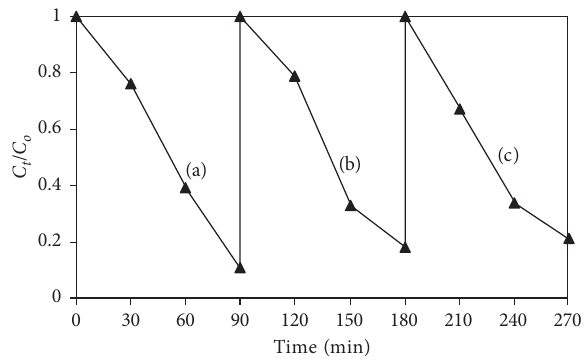
Figure 15: Catalyst’s reuse results: (a) first cycle; (b) second cycle; (c) third